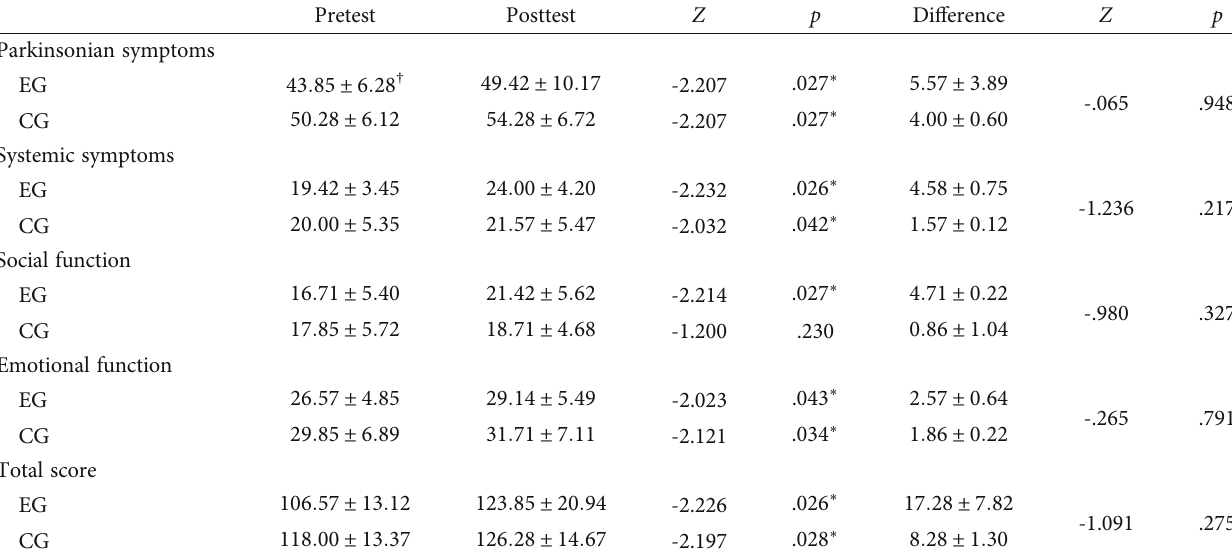
Table 7: Changes of state Parkinson ’ s Disease Quality of Life Questionnaire before and after intervention ( N = 14 ).